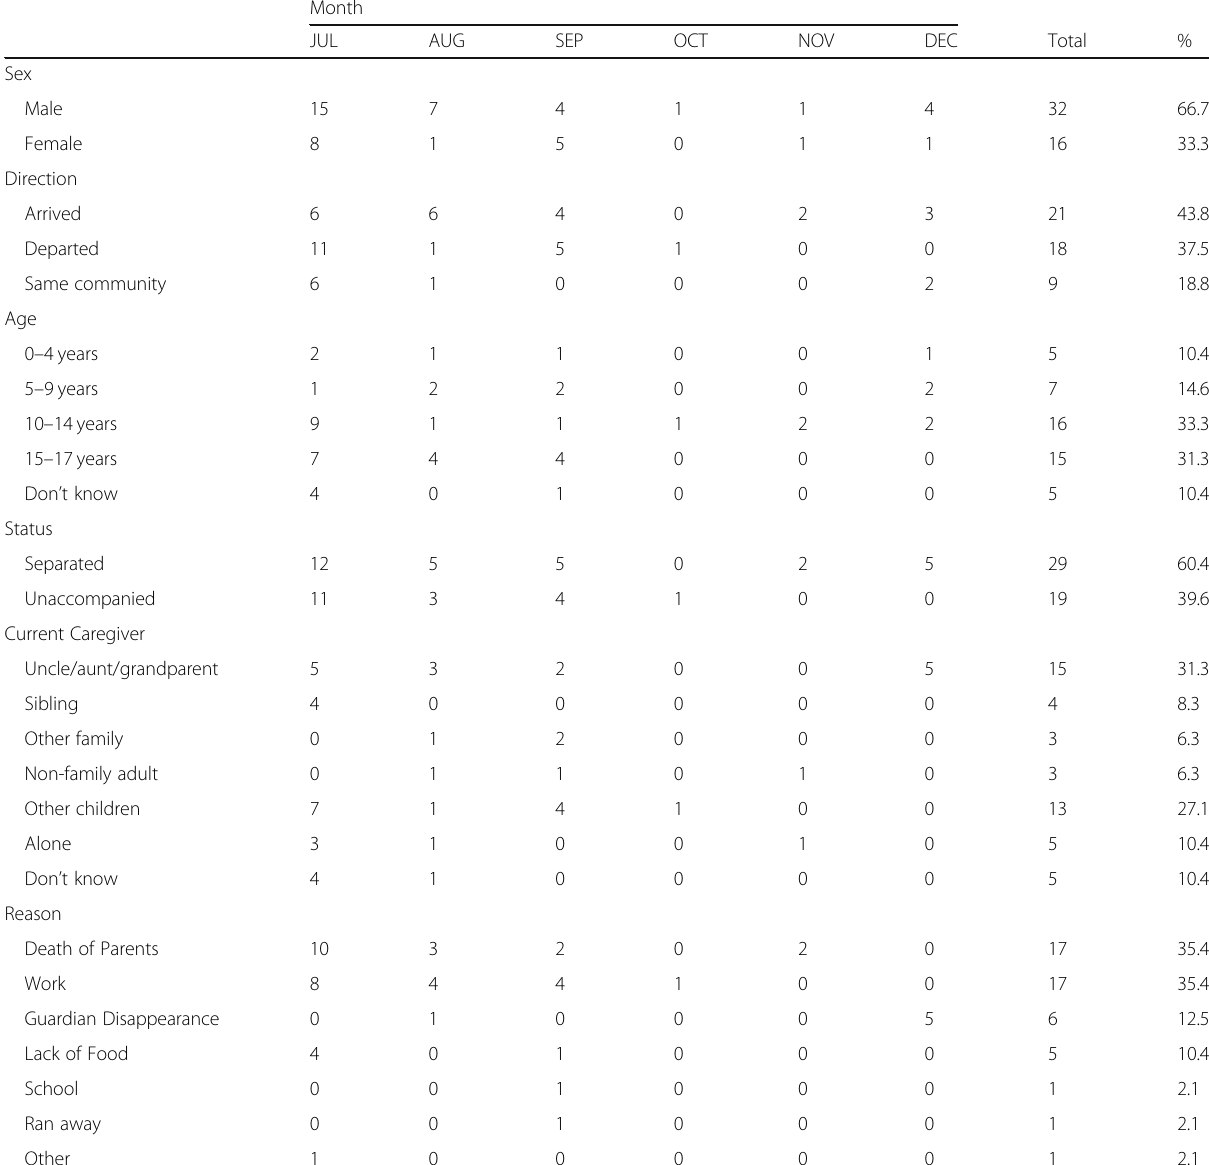
Table 1 Characteristics of UASC by